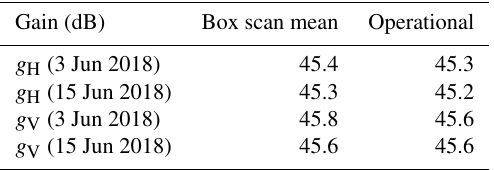
Table 1. Mean antenna gain from box scan data compared to the gain obtained from the operational monitoring. Antenna manufac- turer gain is 45.4 (H) and 45.2dB (V); see also Frech et al. (2013). The DRAO-data-based gain estimate is 45.4dB.